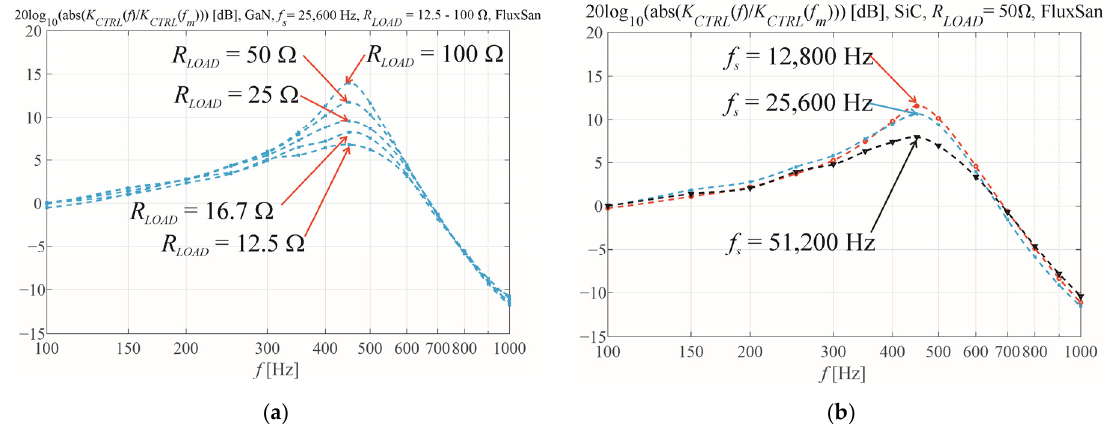
Figure 8. ( a ) Magnitude Bode plots for a bridge composed of GaN transistors, with switching frequency f s = 25,600 Hz and R LOAD = 12.5–100 Ω ; ( b ) magnitude Bode plots for R LOAD = 50 Ω , using SiC transistors and FluxSan core, for f s = 12,800, 25,600, and 51,200